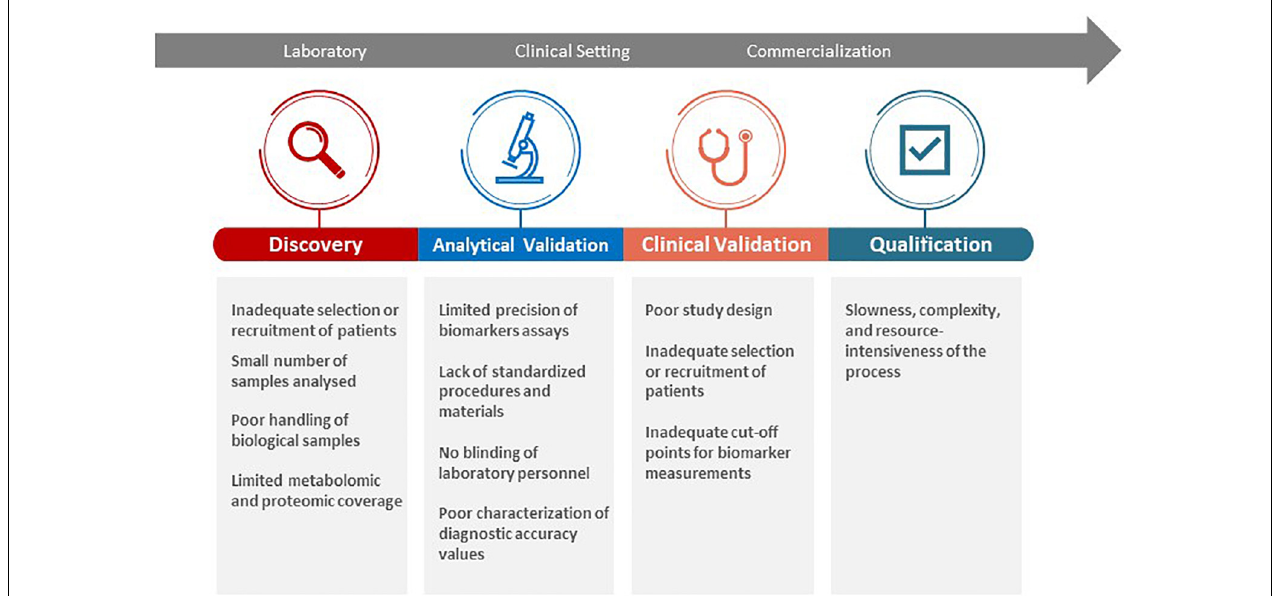
FIGURE 4 | Challenges in biomarker discovery, validation, and qualification for clinical